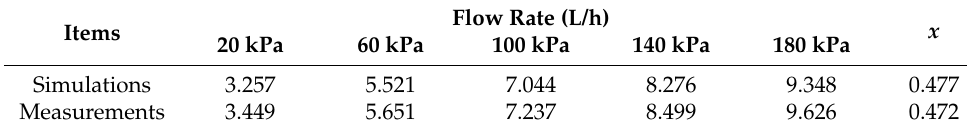
Table 2. Hydraulic performance statistics of SWRLC